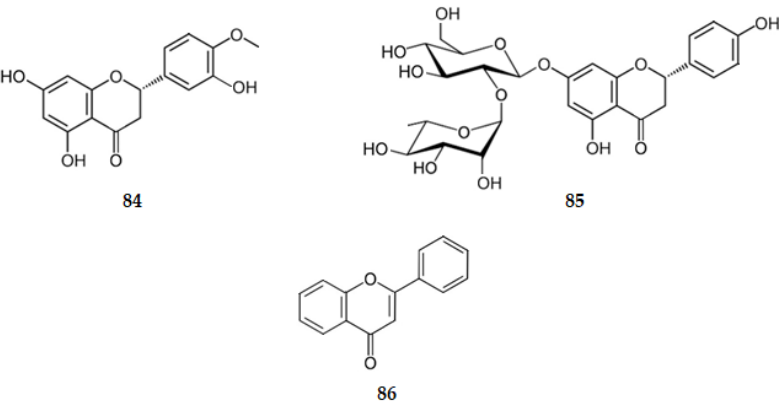
Figure 9. Structure of the flavanones 84 and 85 and of flavone ( 86 ).